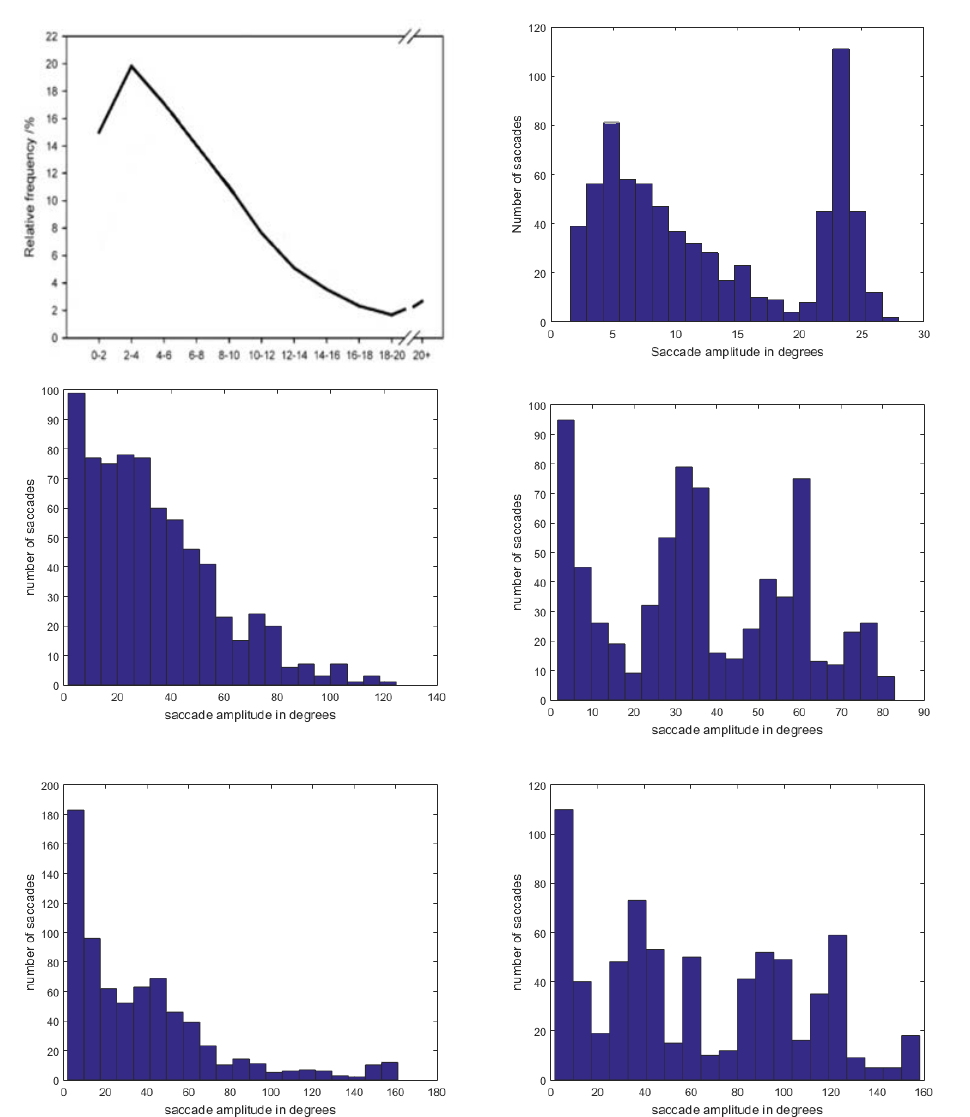
Figure 18. Comparison of saccade distribution amplitudes. Note that the axes vary for each plot. Top Left: The frequency of saccades vs amplitude generated by human subjects in the free-viewing condition. Adapted from Tatler et al. (2006). Top Right: The frequency of saccades vs amplitude generated by STAR. Middle Left: The frequency of saccades vs amplitude generated by CAS without IOR decay. Middle Right: The frequency of saccades vs amplitude generated by CAS with the same IOR decay as STAR. Bottom Left: The frequency of saccades vs amplitude generated by AIM without IOR decay. Bottom Right: The frequency of saccades vs amplitude generated by AIM with the same IOR decay as